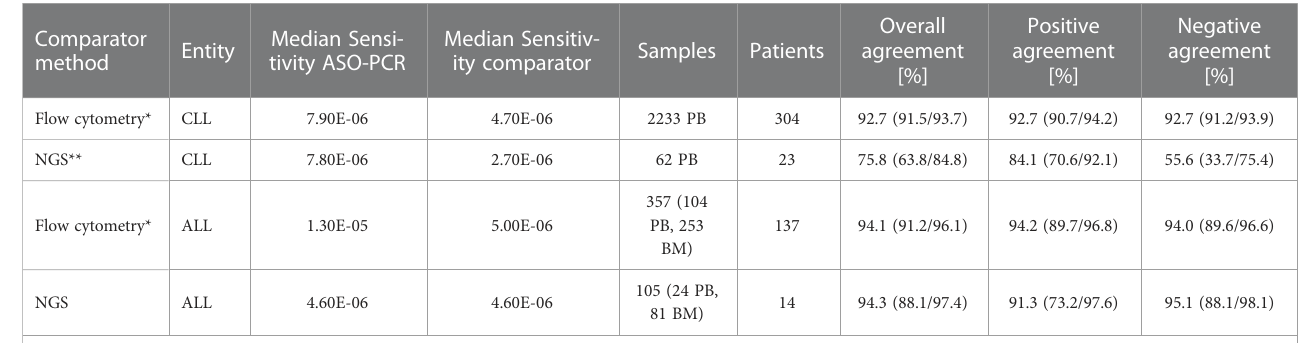
TABLE 1 Accuracy of ASO-PCR at the MRD cut-off 10 -4